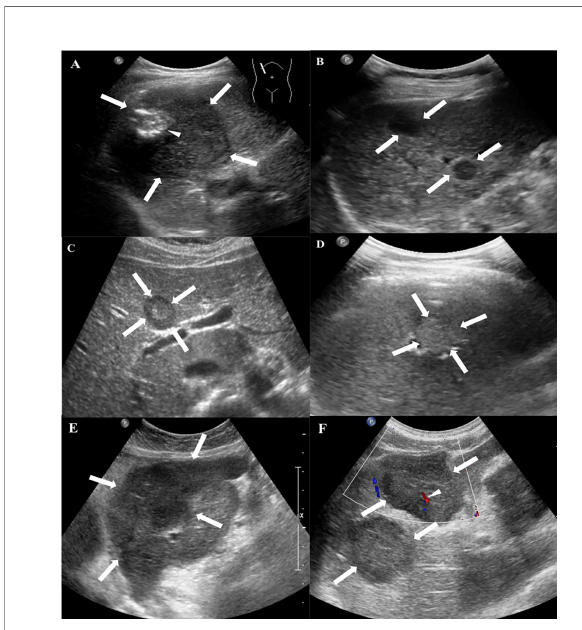
TABLE 2 | The US features of HEHE in 20 patients.